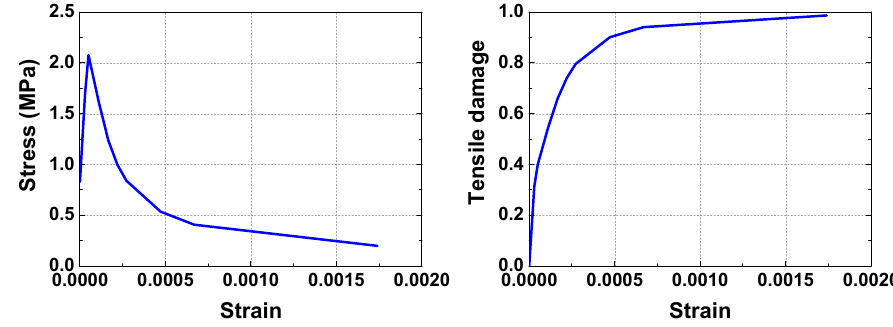
Figure 8. The CDP model parameters of the II-conventional concrete. Table 2. Dynamics material parameters for the dam-foundation system.